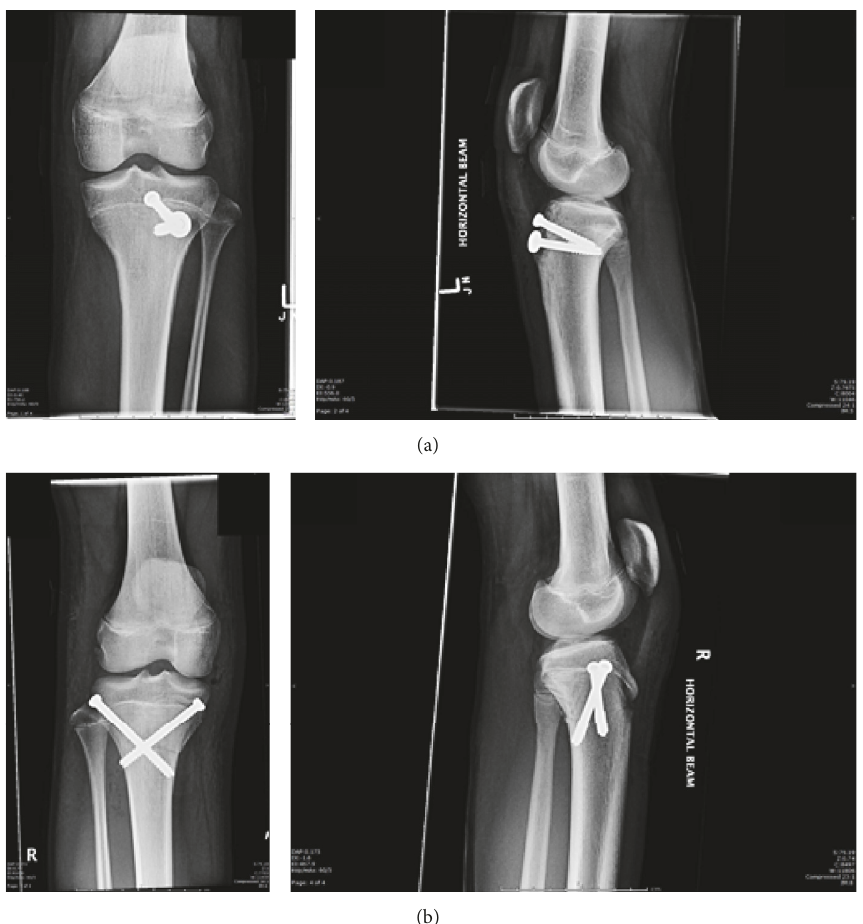
Figure 5: Day 1 postoperative plain radiographs of left (a) and right (b) knees following